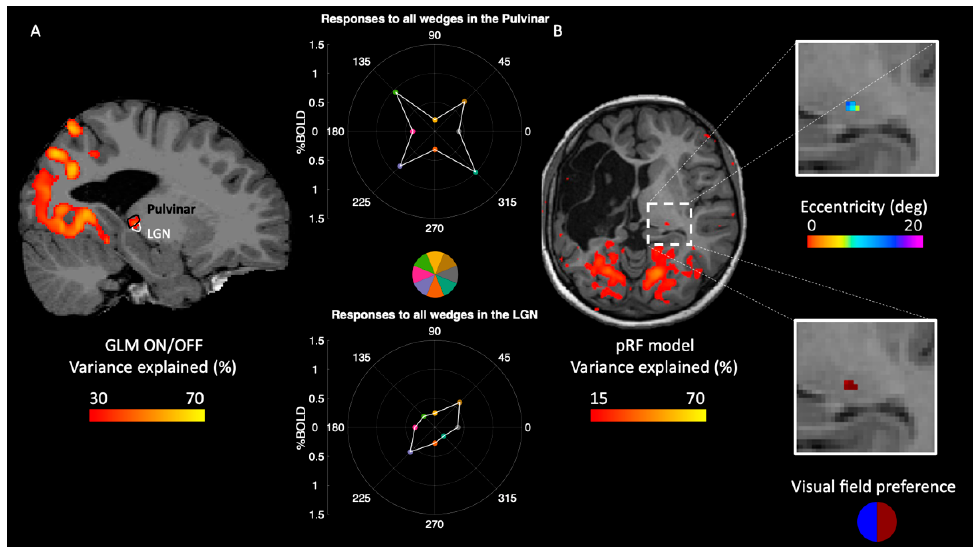
Figure 3. GLM results in right thalamus. ( A ) Variance explained by the GLM (all wedges vs. blank) plotted on one slice of the anatomical brain. Black and white contours plot the LGN and pulvinar extracted from the atlas. The inset shows responses to each of the wedges extracted from both ROIs. ( B ) pRF mapping of the thalamus showing the eccentricity and visual field preference maps. pRF maps are thresholded with the variance-explained threshold of 15%.